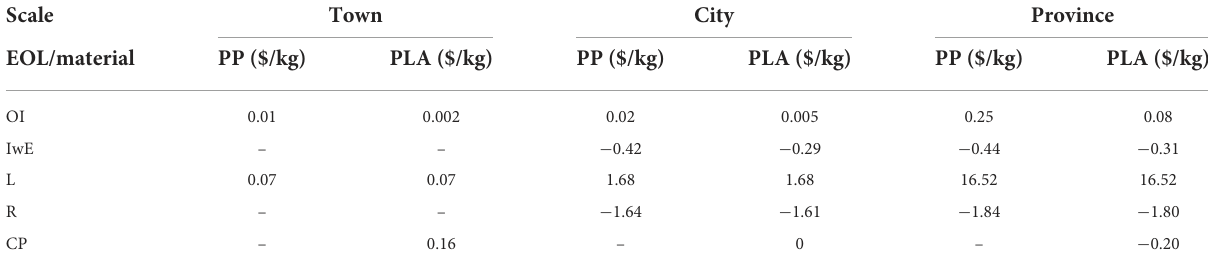
TABLE 5 TEA of different municipal practices for PP and PLA (OI, 100% Open Incineration; IwE, 100% Incineration with energy recovery; L, 100% Landfill; R, 100% Recycling; CP, 100% Composting).